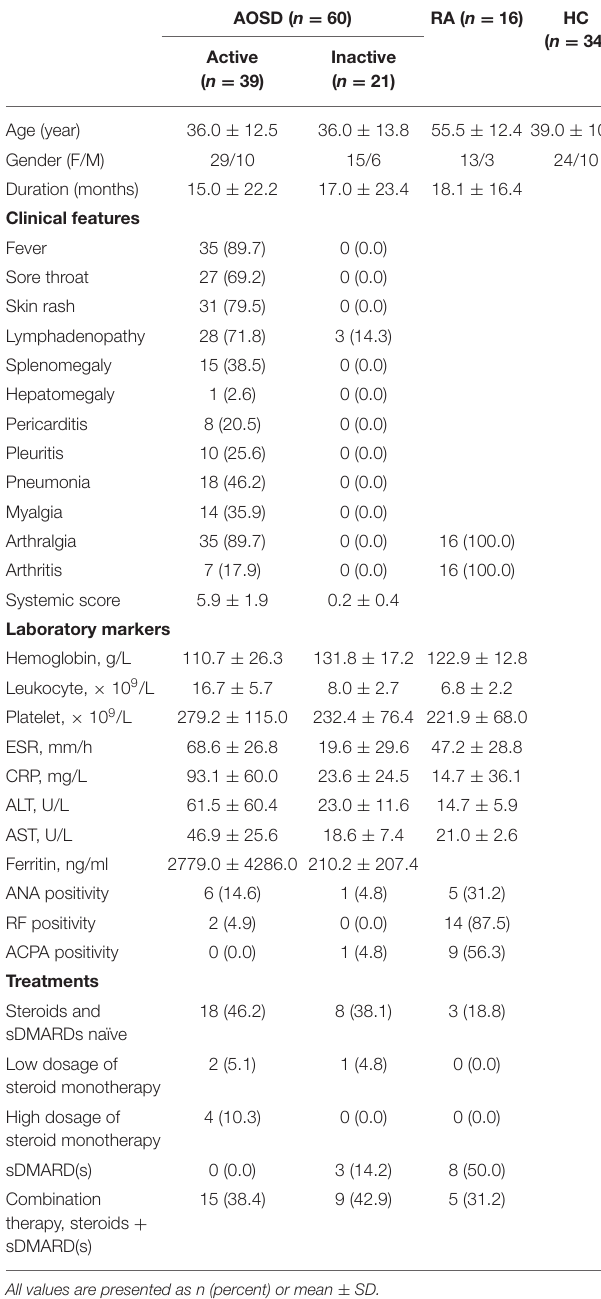
TABLE 1 | Clinical characteristics of patients at the time of